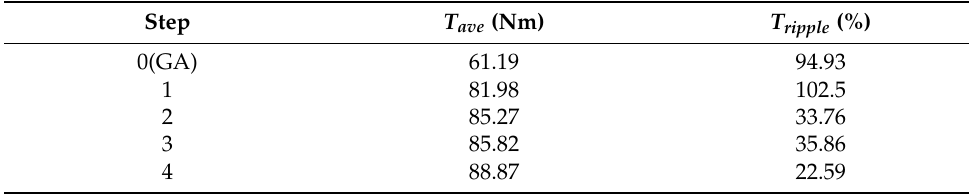
Table 3. Performance comparison by ON-OFF